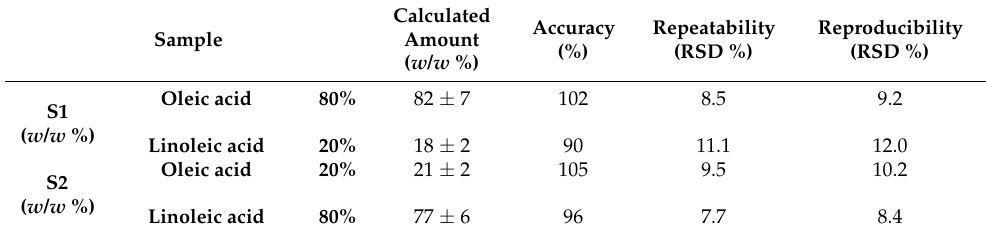
Table 2. Accuracy, repeatability, and reproducibility values.